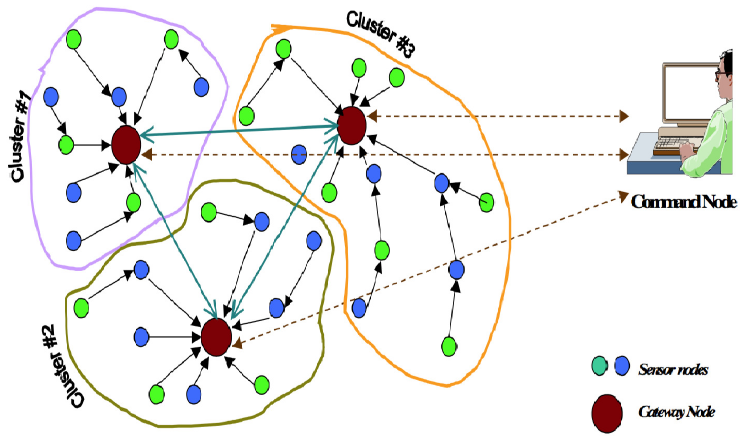
Figure 1. Architecture of a multi-gateway clustered sensor network.